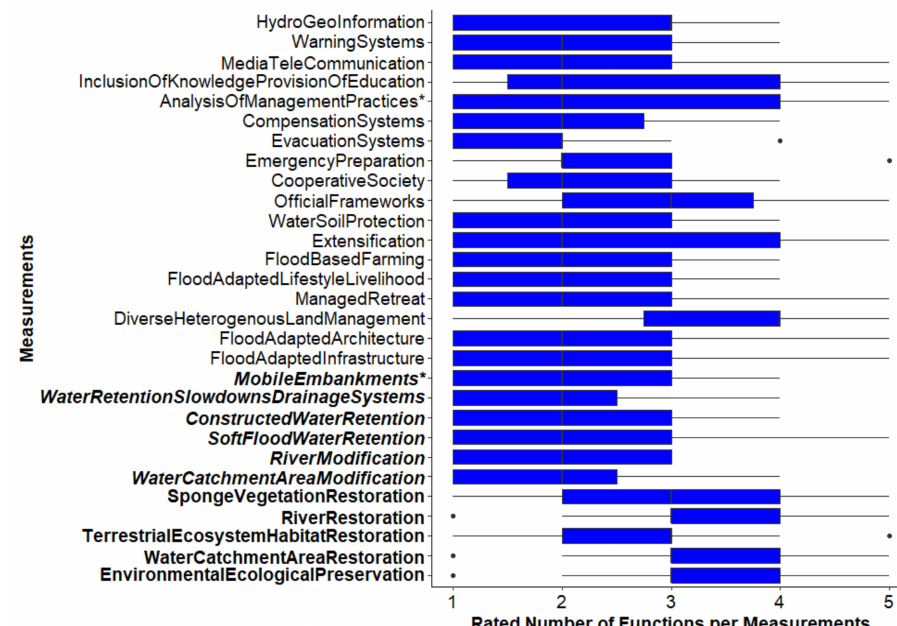
Figure 6. Rated multifunctionality of measures by experts (N = 33). Multiple choice was possible. * Only represented in sub-data set 2 (SDS-2) about FM in non-European rural mountain areas. Instrumental (plain), structural ( bolditalic ), and natural solutions ( bold ).